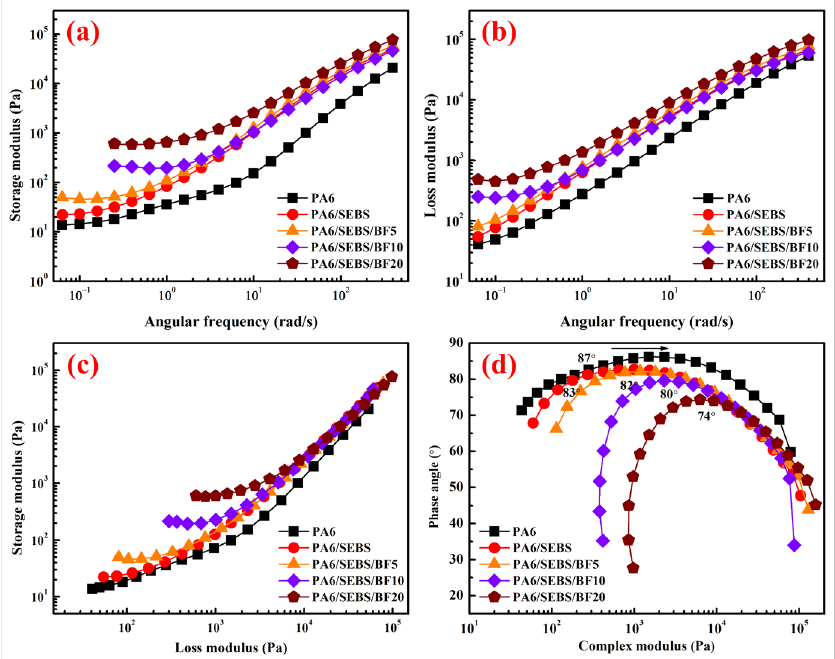
Figure 2. ( a ) Storage modulus versus frequency curves, ( b ) loss modulus versus frequency curves, ( c ) Han plots, and ( d ) van Gurp−Palmen plots of PA 6/SEBS/BF composites.